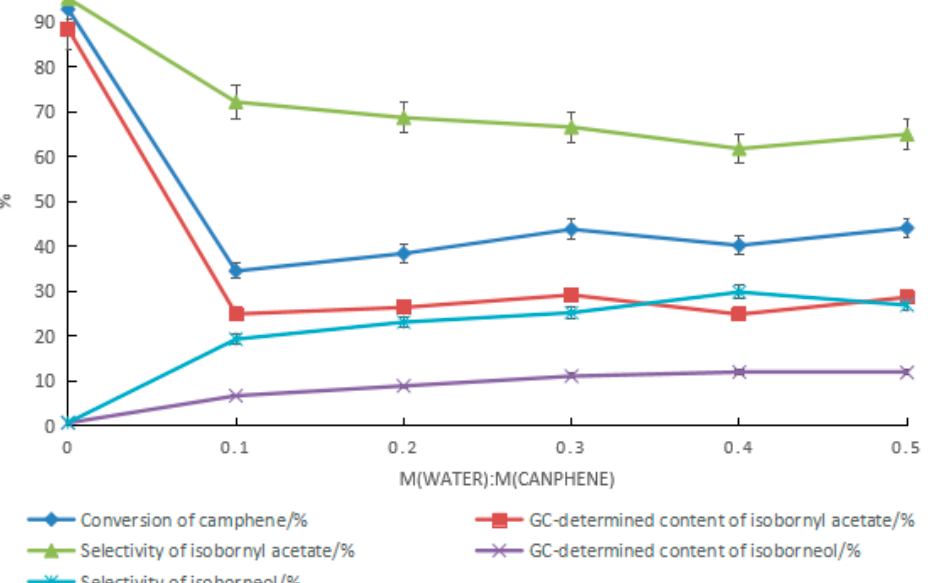
Figure 6. Effect of water on the reaction when tartaric acid–boric acid was used as the catalyst. Reaction conditions: m(camphene):m(acetic acid):m(tartaric acid):m(boric acid) = 10:25:0.5:0.4, reaction temperature of 70 °C, and reaction time of 18 h.